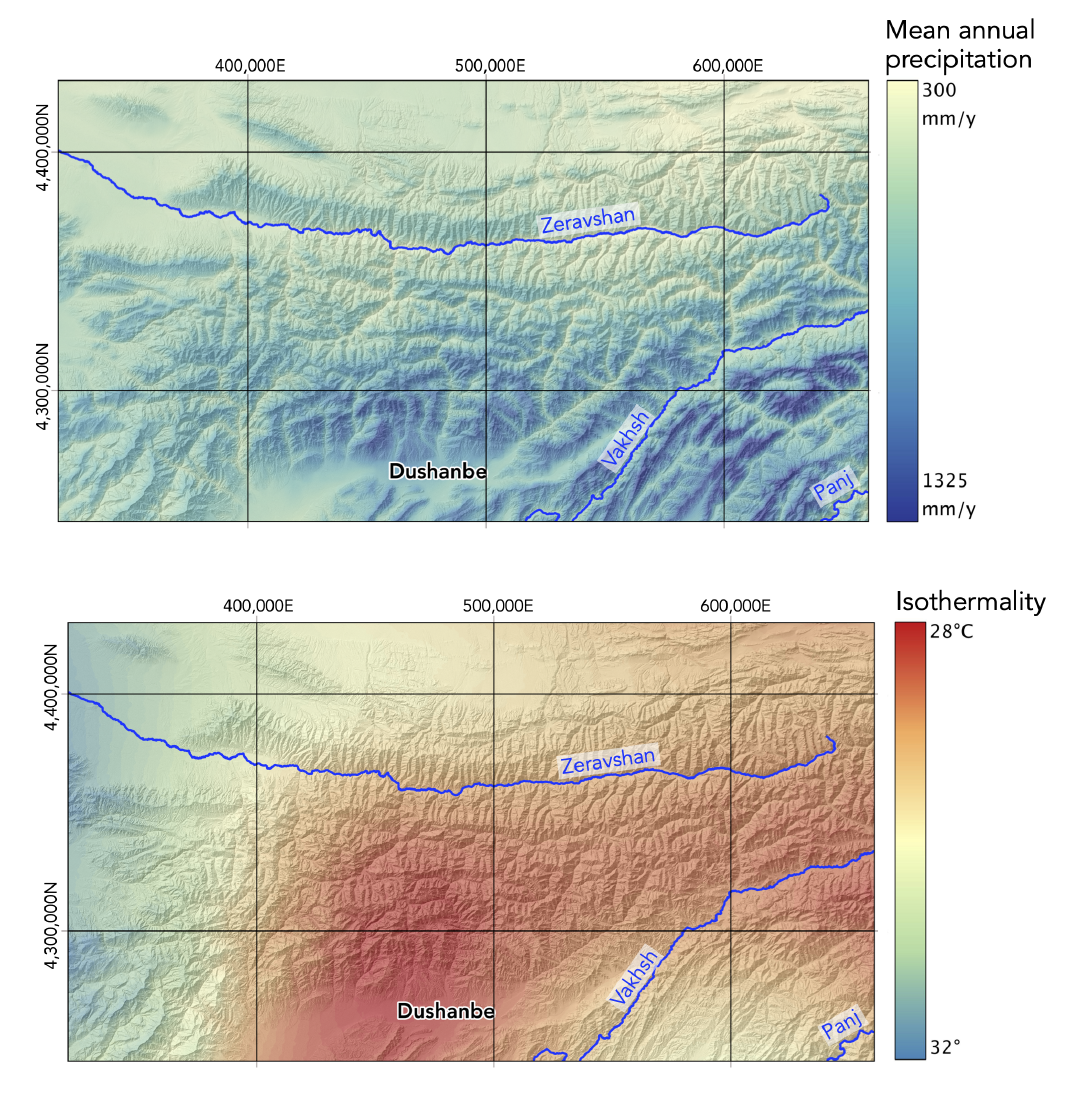
Figure A2. Climatic indices.